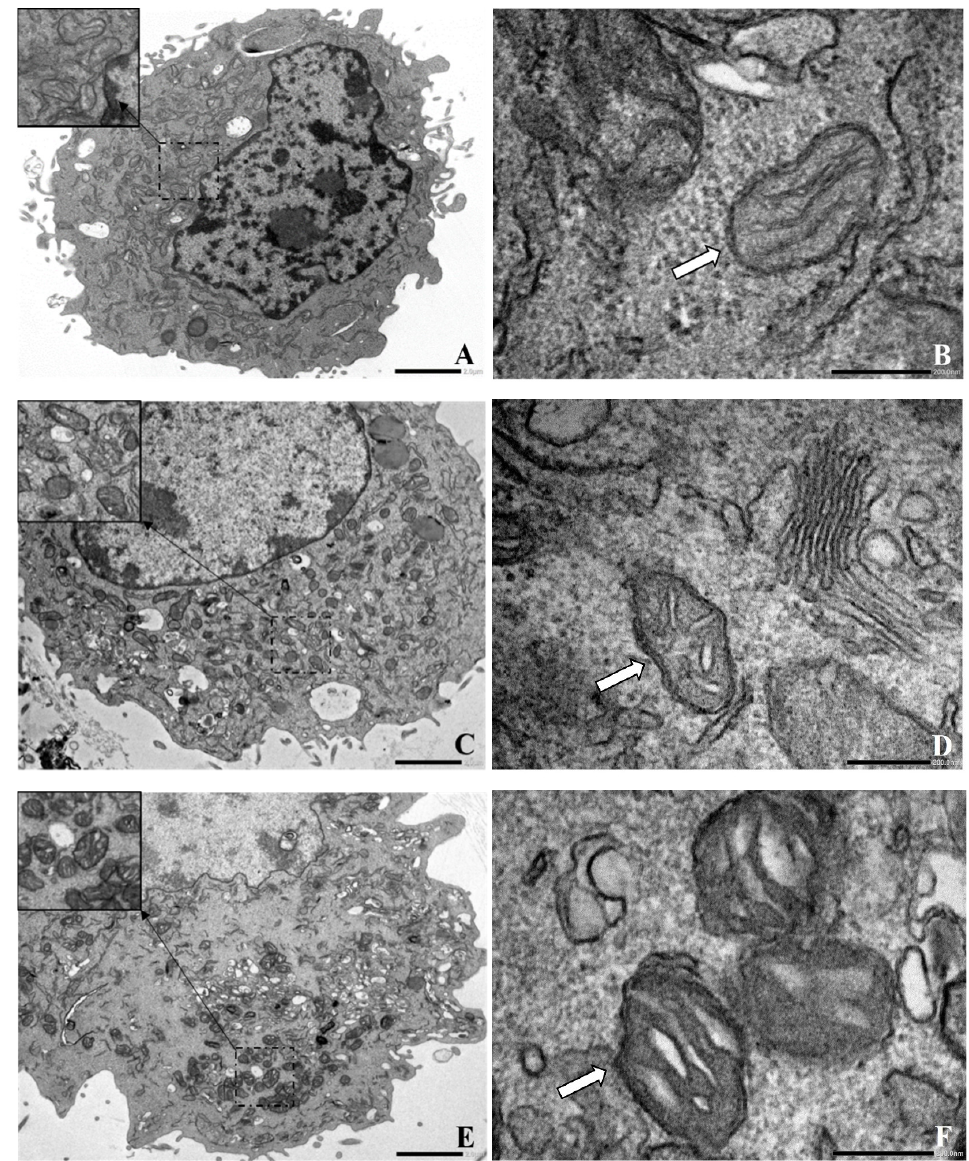
Figure 7. TEM ultrastructural evaluation of the interaction between the AgNPs biologically synthe- sised by the fungus C. thermophilum cell-free extract and skin fibroblasts from the murine embryo Balb/c 3T3 NIH cell line. ( A ) Negative control (Balb/c 3T3 NIH cells without treatment). ( B ) Mito- chondria organelle of Balb/c 3T3 NIH cells without treatment. ( C ) Balb/c 3T3 NIH cells exposed to a non-toxic AgNP concentration (IC 20 = 91.77 ± 24.24 µg/mL), demonstrating no significant cell dam- age or alteration at the ultrastructural level. ( D ) Mitochondria organelle of Balb/c 3T3 NIH cells exposed to a non-toxic AgNP concentration (IC 20 ). ( E ) Balb/c 3T3 NIH cells exposed to an IC 50 (119.69 ± 21.15 µg/mL), showing that the cell cytoplasm was damaged. ( F ) Mitochondria organelle of Balb/c 3T3 NIH cells exposed to an IC 50 with an evident morphological alteration.